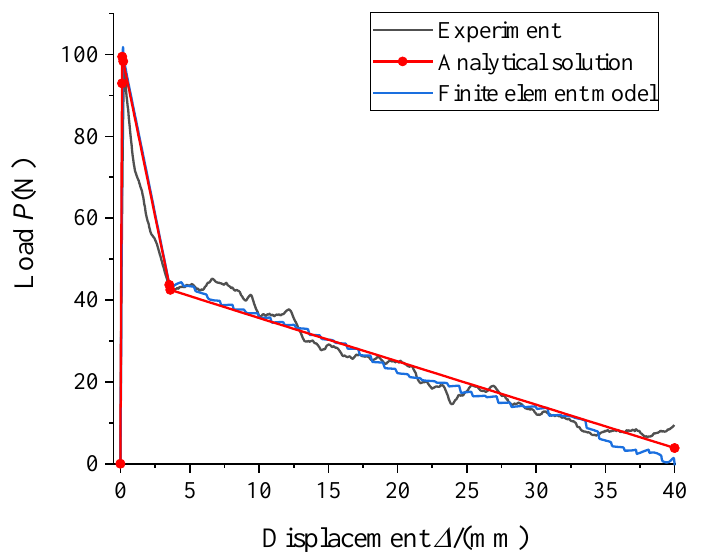
Figure 24. Load–displacement curves from the pullout tests, analytical solutions and FE simulations (group U).